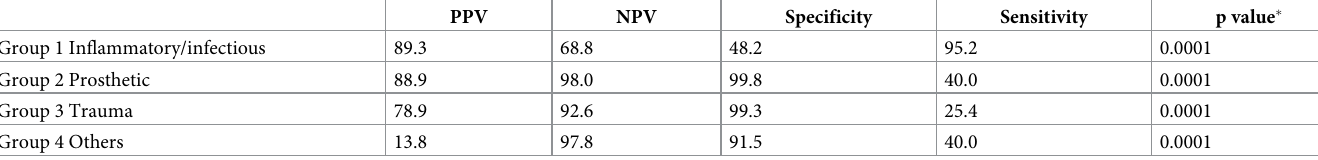
Table 2. Predictive values, sensitivity, and specificity of prediagnosis at the triage level versus clinical diagnosis in adults